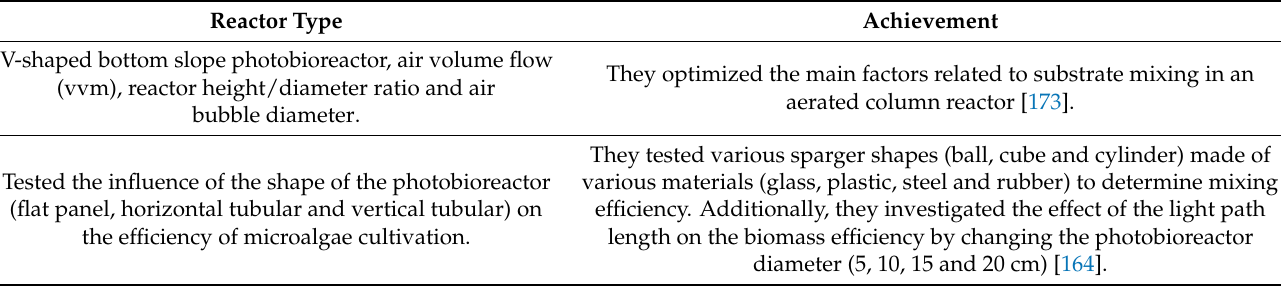
Table 12. The experimentally tested popular types of photobioreactors and achieved